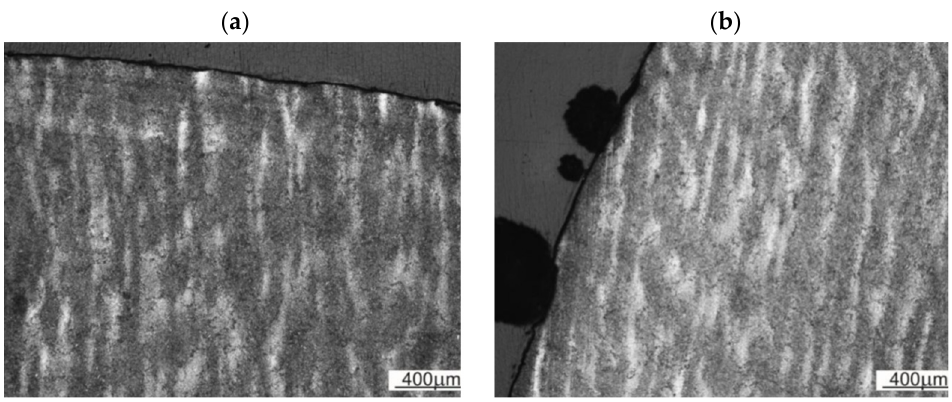
Figure 15. Path of fracture development in relation to the banding structure of the die.